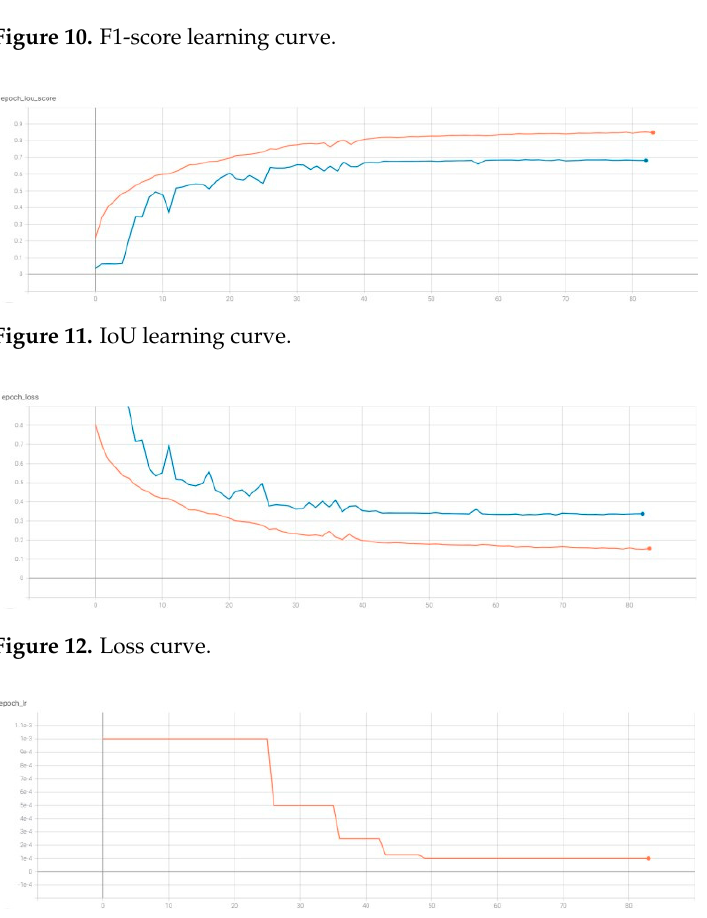
Figure 13. Learning rate